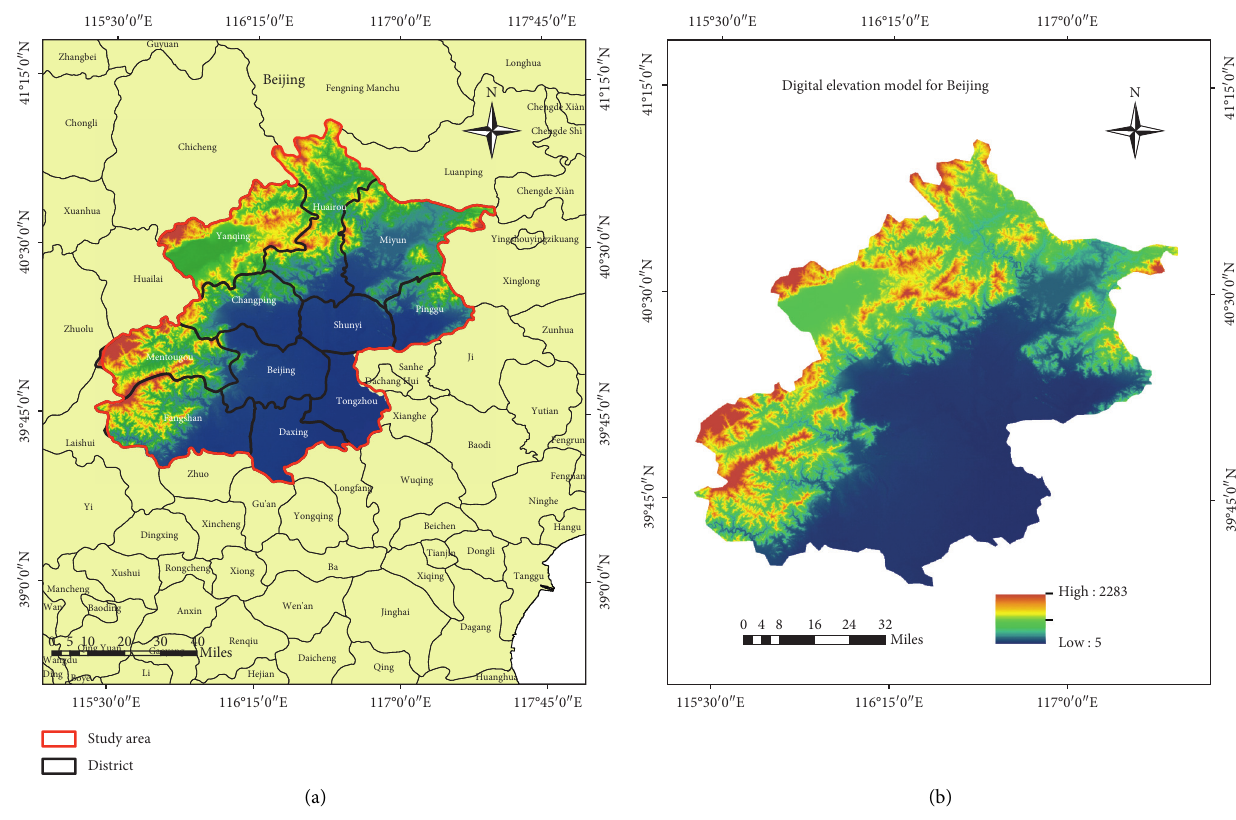
Figure 1: Beijing city’s (a) location and (b) digital elevation model (DEM). Table 1: Image information will be used in the study.